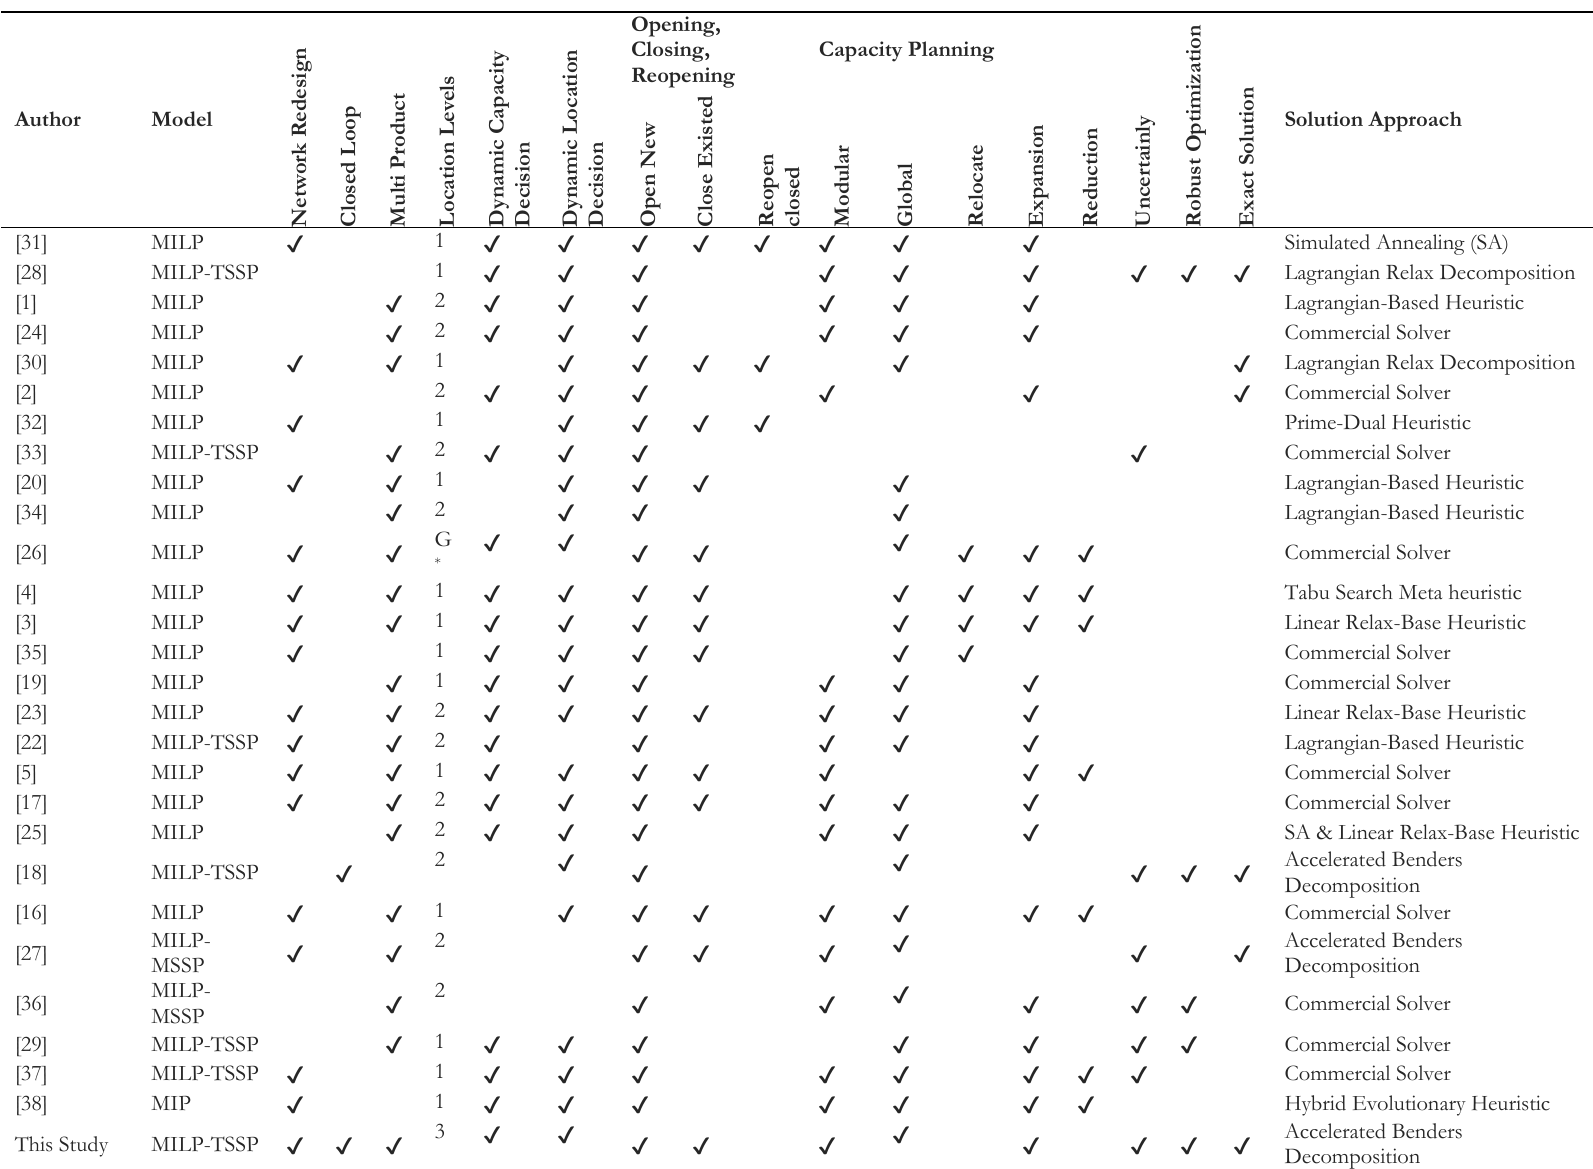
Table 1. Literature